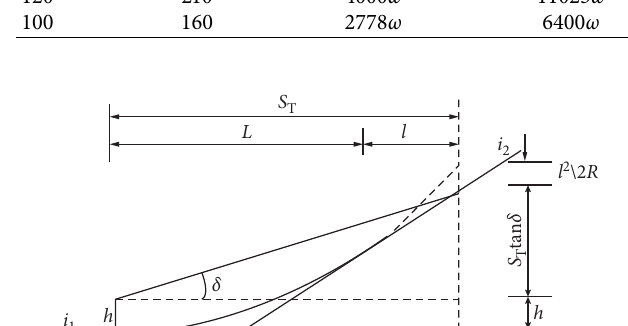
Figure 7: Distance of headlight irradiation ( L < S